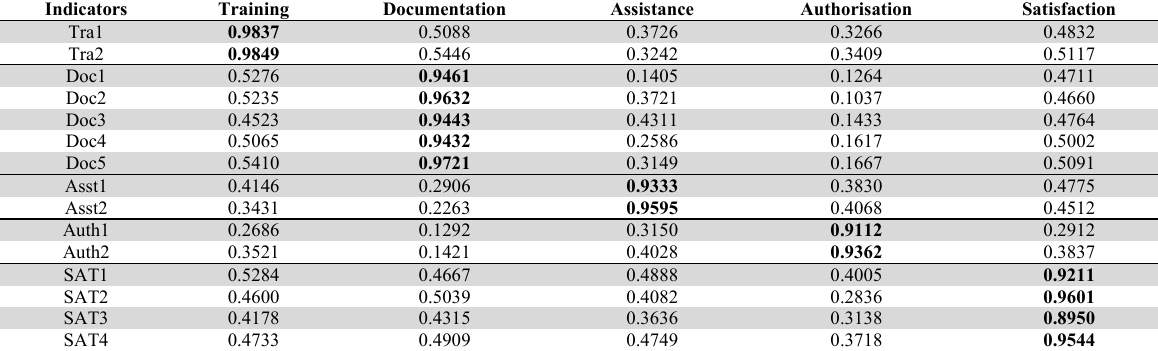
Factor loadings (bolded) and cross loadings